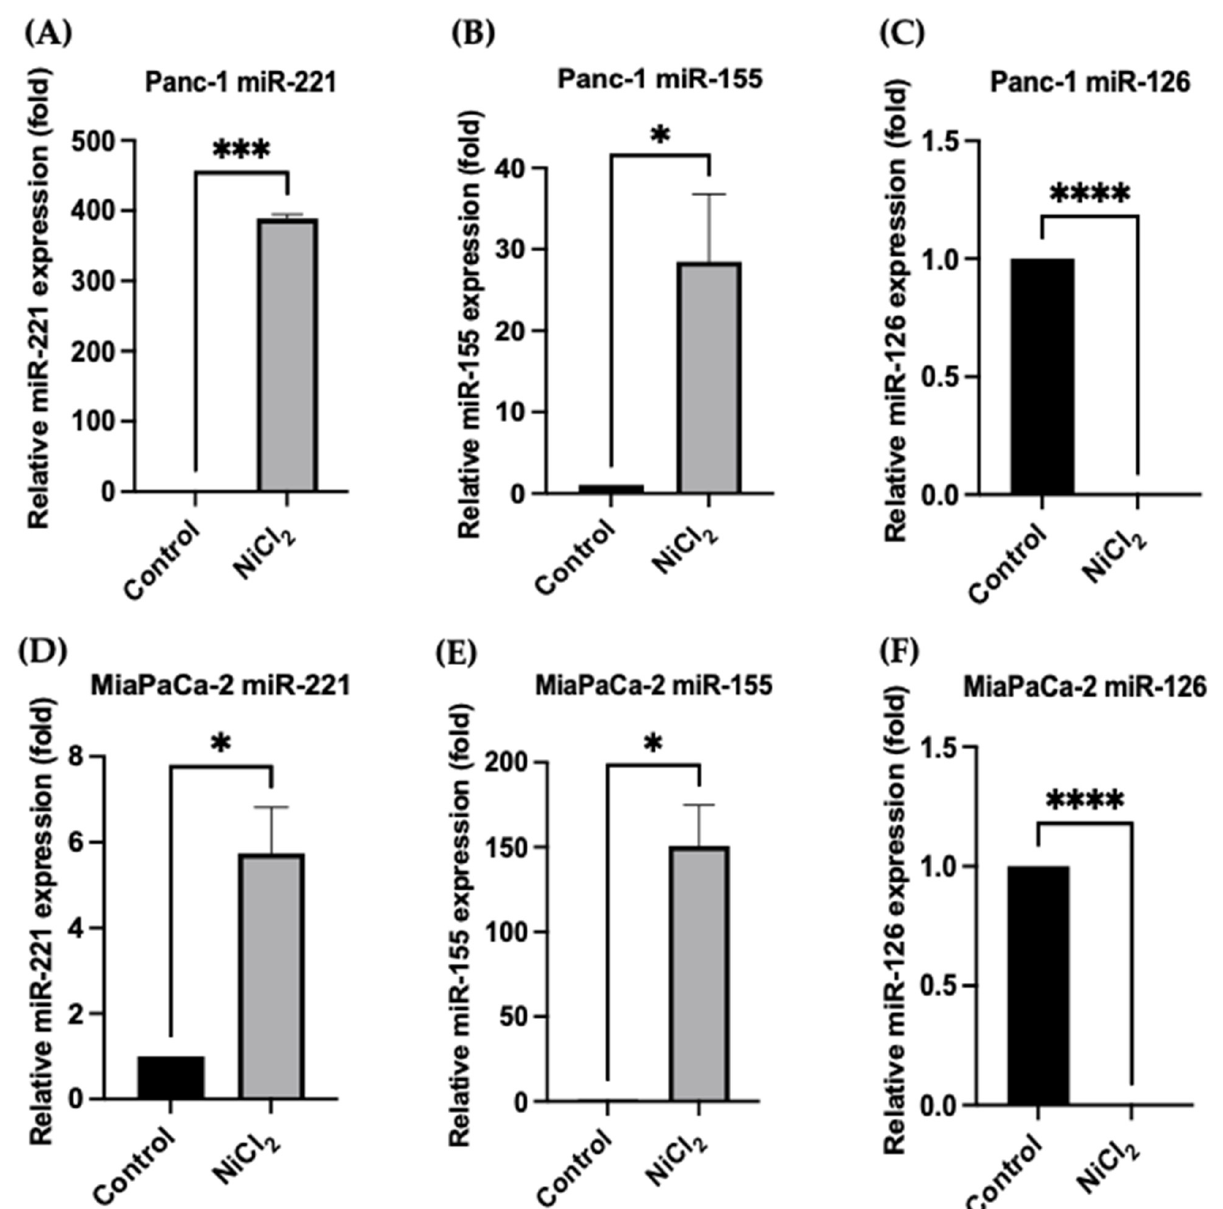
Figure 7. NiCl 2 treatment-mediated effects on miR expression levels in PDAC cells. ( A – C ): Effects of NiCl 2 in the Panc-1 cell line: miR-221 relative expression levels ( A ); miR-155 relative expression levels ( B ); miR-126 relative expression levels ( C ). ( D – F ): Effects of NiCl 2 in the MiaPaCa-2 cell line: miR-221 relative expression levels ( D ); miR-155 relative expression levels ( E ); miR-126 relative expression levels ( F ). NiCl 2 treatment effects were evident in the expression levels of miR-221 ( p < 0.001; Panc-1, p < 0.05; MiaPaCa-2), and miR-155 ( p < 0.05 for all) compared to the control cells, while the expression levels of miR-126 were significantly downregulated ( p < 0.0001 for all). The column graphic represents the average of three replicates of RNA isolated from the Panc-1 and MiaPaCa-2 cell lines. Data normalized according to RNU6 expression by fold analysis (n = 3, p < 0.05); exact p -values are indicated ( * p ≤ 0.05; *** p ≤ 0.001; **** p ≤ 0.0001); error bars indicate SD.